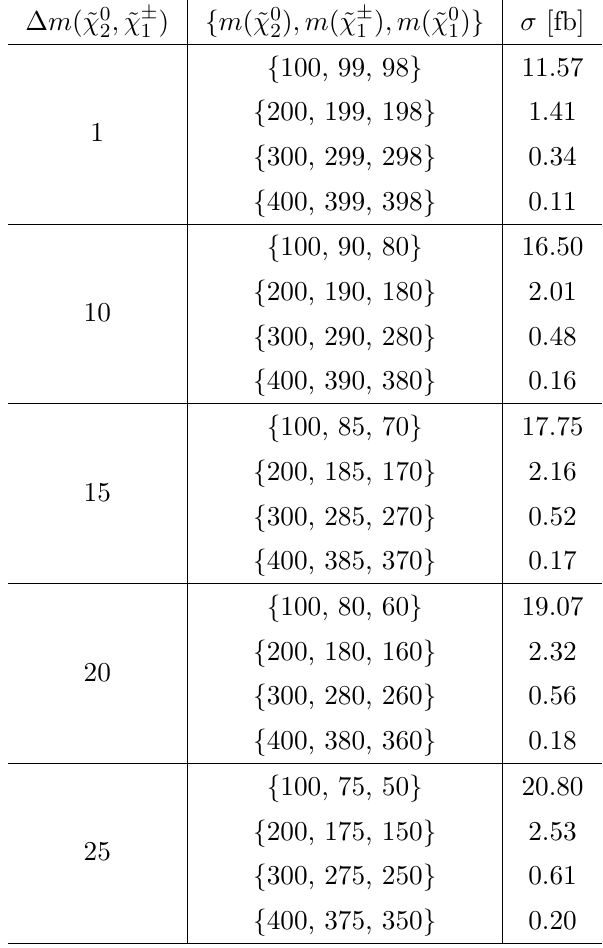
Table 1 . Signal cross sections for different benchmark points.